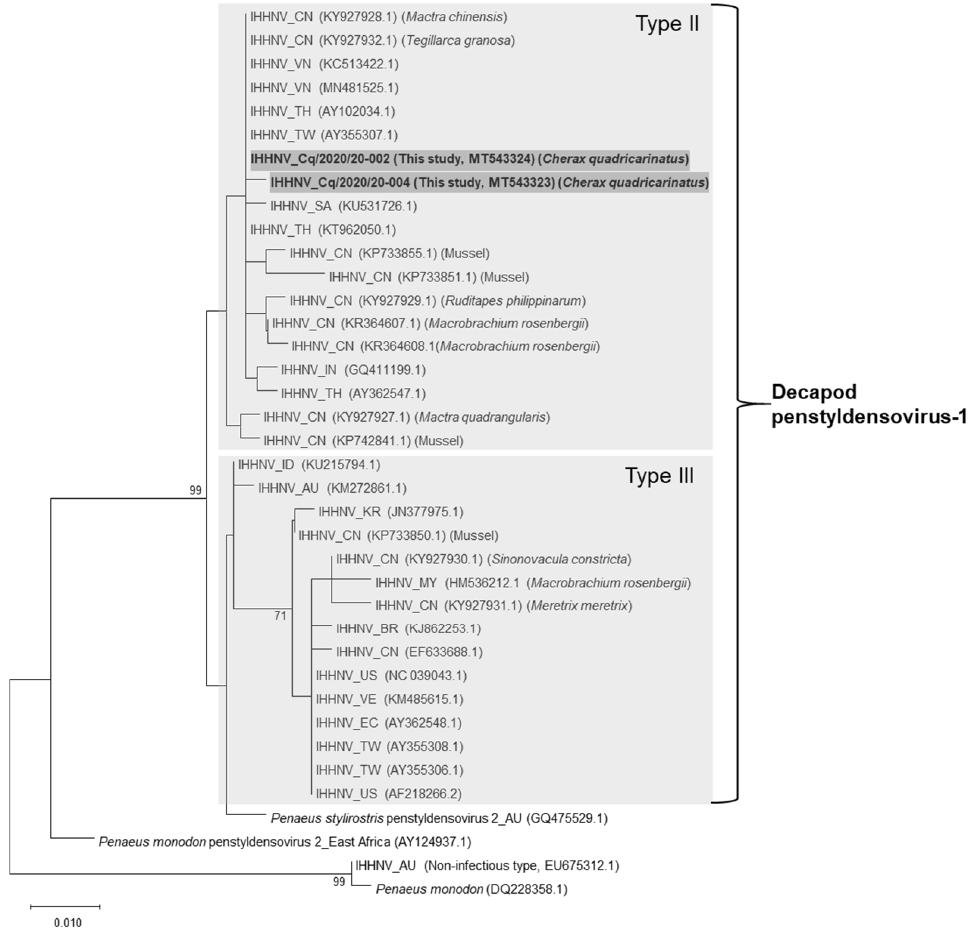
Figure 2. Phylogenetic tree based on the nucleotide sequences of the partial nonstructural protein- coding region (~380 bp) in the representative IHHNV strains including the strain detected in two batches of Cherax quadricarinatus (Sample 20-002; MT543324; Sample 20-004, MT543323) imported from Indonesia. The maximum-likelihood tree also included non-infectious endogenous IHHNV types (EU675312.1 and DQ228358.1), which were used as an outgroup. Bootstrap values were calculated from 1000 replicates. The scale bar (0.01) represents 1 substitution per 100 nucleotides.